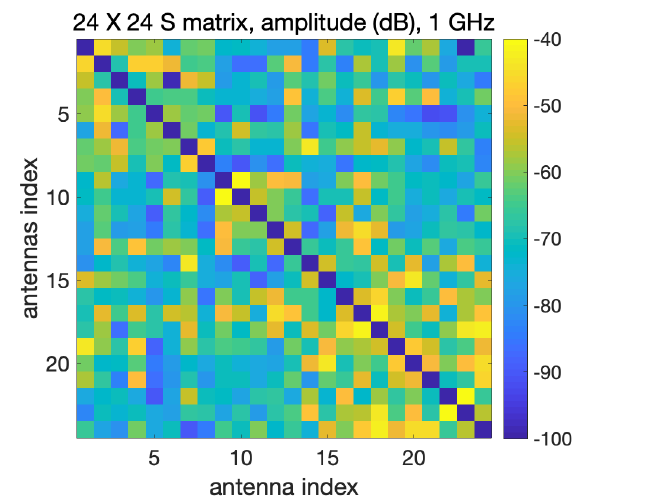
Figure 3. The 24 × 24 scattering matrix measured in the presence of the head phantom; the self-terms are forced to zero.